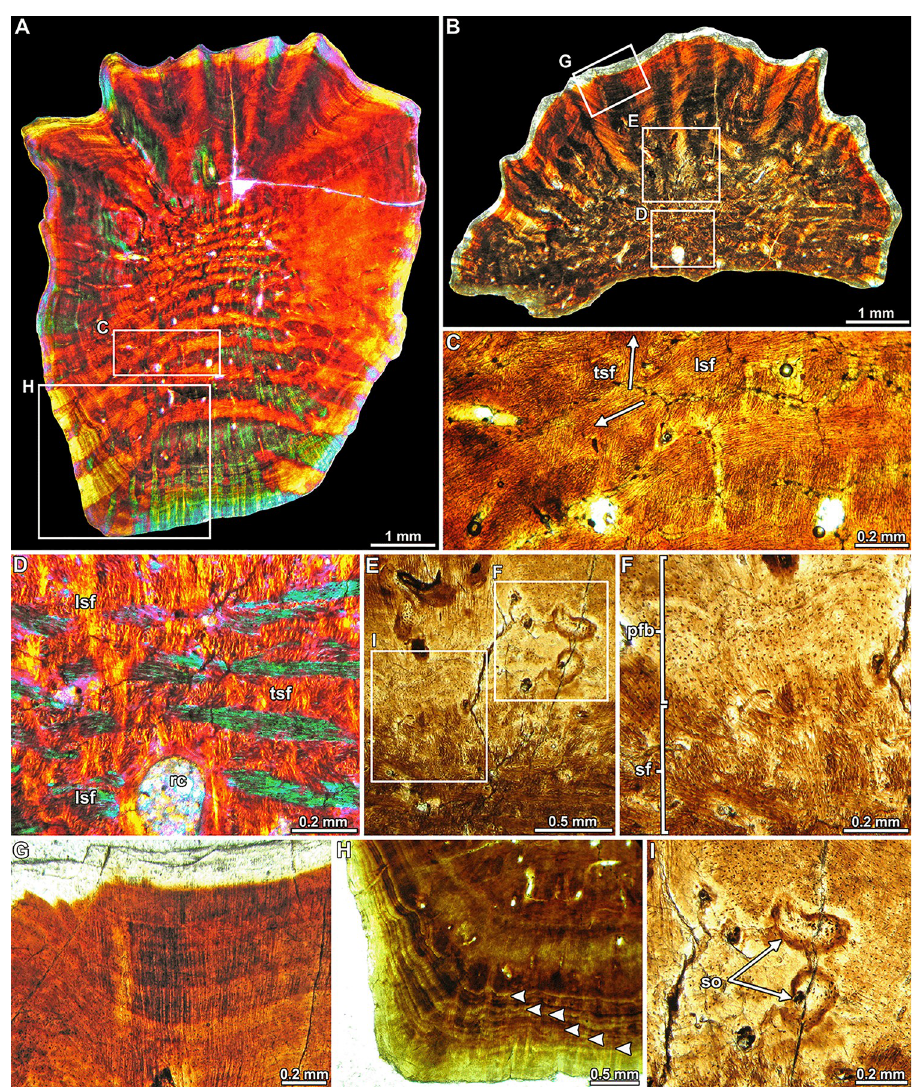
Fig 4. Bone histology of ankylosaur interstitial ossicles. (A-B) Complete sections of elements MPM-PV-18805.19 (A) and MPM-PV-18805.22 (B). In both images the superficial surface is oriented toward the top of the figure. The deep cortex of MPM-PV-18805.v-w is not preserved. The complex pattern of mineralized structural fiber bundles is clearly observed in the inner core and deep cortex of MPM-PV-18805.m-p. (C-D) Primary bone tissue composed by intercrossed bundles of mineralized structural fibers. White arrows in (C) signal the orientation of the fiber bundles. (E, F) General view (E) and detail (F) of the transition between the inner core (formed by structural fibers) and the external cortex (mostly formed by parallel fibered bone). (G) Detail of the outer cortex at the superficial portion of the ossicles. Note the profuse abundance of mineralized collagenous fibers. (H) Lines of arrested growth in the deep cortex (white arrowheads). (I) Detail of secondary osteons. Pictures have been taken under normal transmitted light (C, E-I), cross-polarized light (B) and cross-polarized light with a lambda filter (A and D). The epoxy resin layer that surrounds the elements in (A) and (B) has been digitally erased to enhance visibility. Abbreviations: lsf, longitudinally sectioned structural fiber bundles; pfb, parallel fibered bone; sf, structural fibers; tsf, transversally sectioned structural fiber bundles; rc, resorption cavity; so, secondary